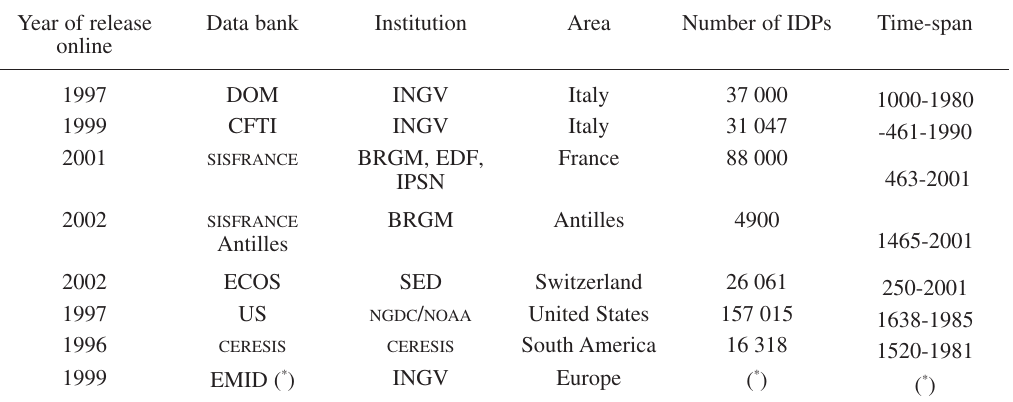
Table I. Online available intensity